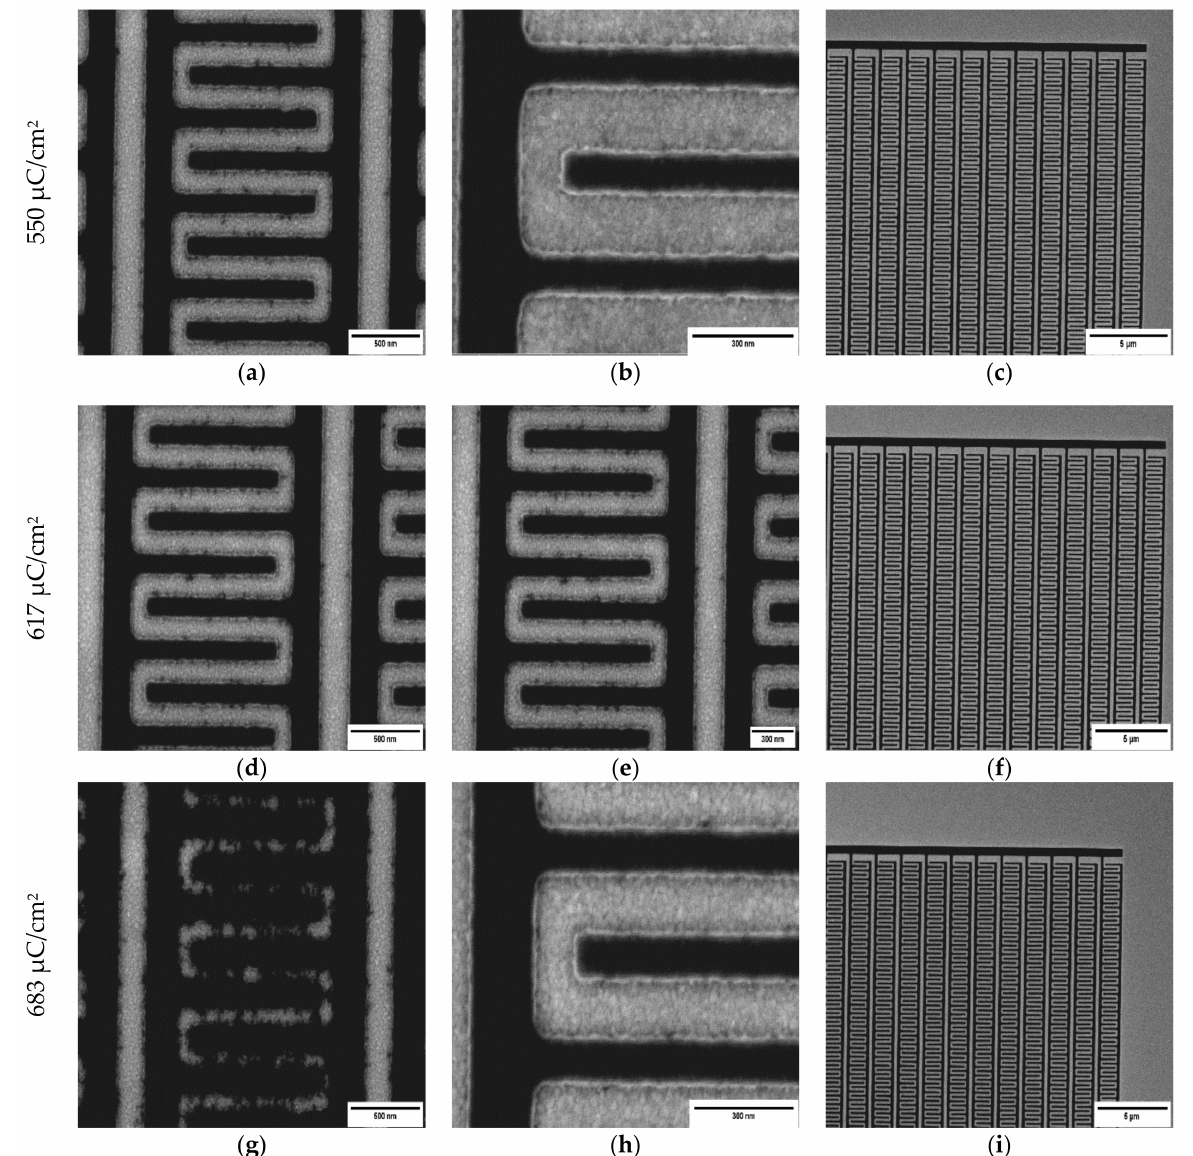
Figure 2. Scanning electron microscope (SEM) images at the center ( a , d , g ), edge ( b , e , h ) , and overview ( c , f , i ) of the devices for 550 µ C cm − 2 , 617 µ C cm − 2 , and 683 µ C cm − 2 doses, respectively.